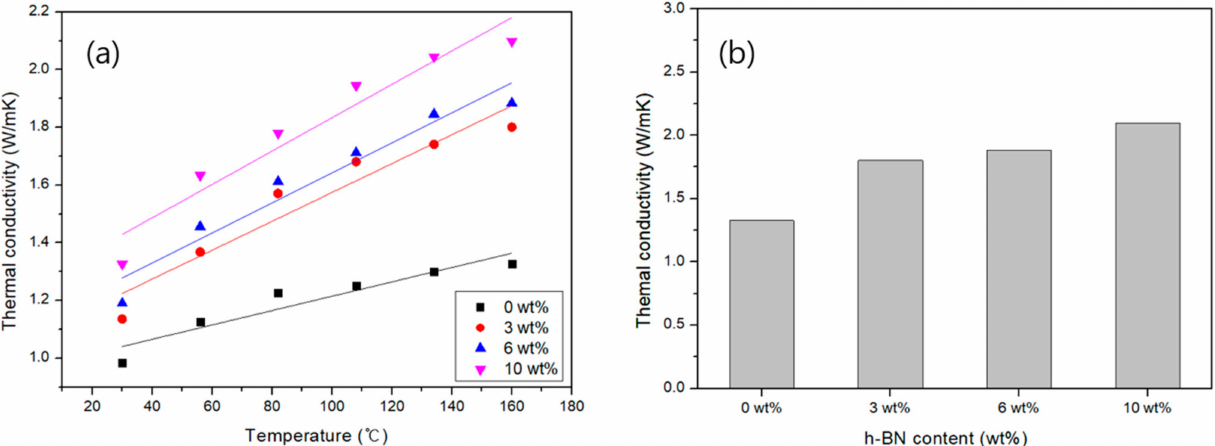
Figure 15. Thermal conductivities of Carbon/APA (h-BN) with different wt% of h-BN ( a ) with temperature, and ( b ) at 160 ◦